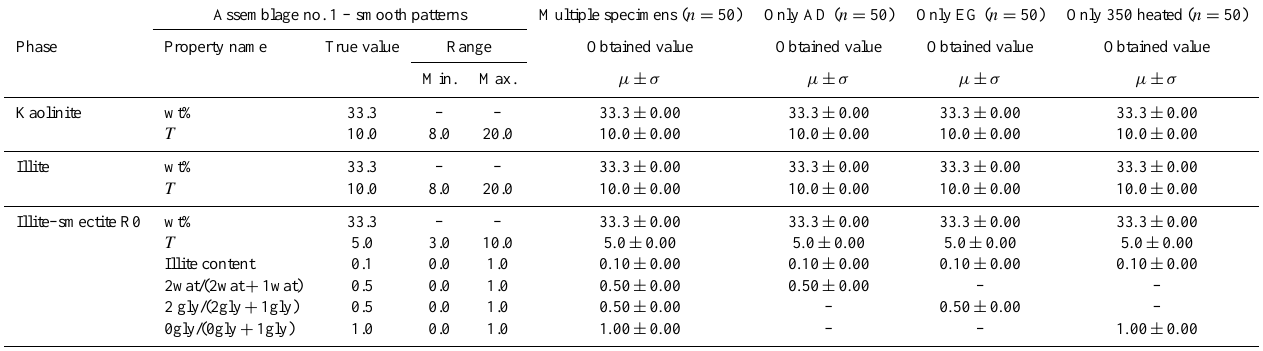
Table 5. Overview of the means and standard deviations for weight fractions and refined parameters for assemblage 1 using smooth patterns. Assemblage no. 1 – smooth patterns